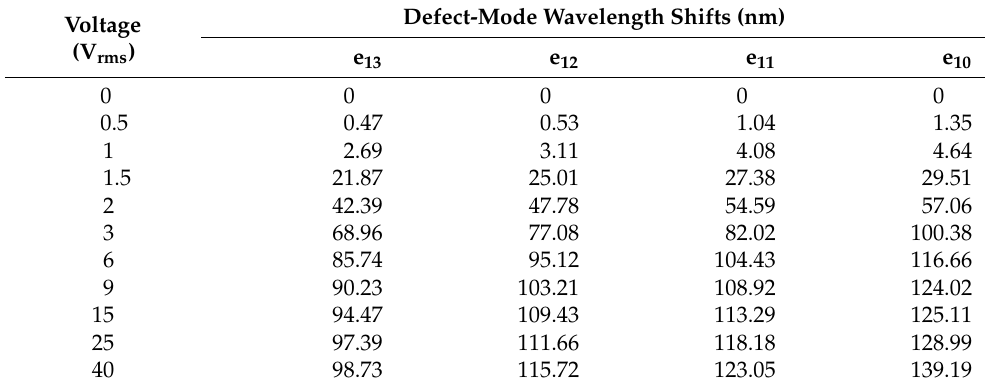
Table 2. Calculated defect-mode shifts in wavelength at various voltages. The blueshift of each e -mode varies from 0 at 0 V to a nonzero value at a voltage V given in the left column. ( d = 5.15 μm). Voltage (V rms